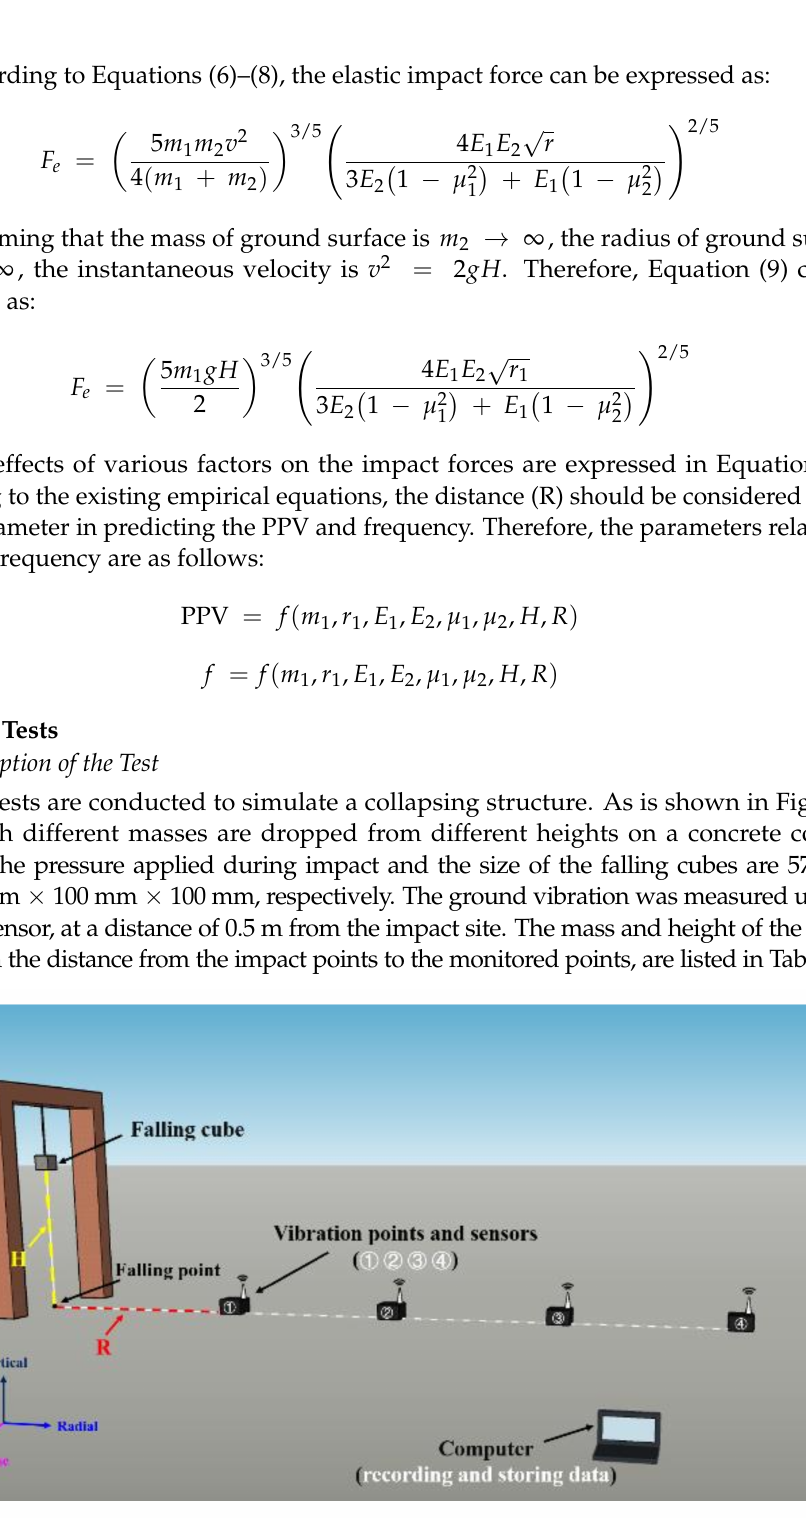
Figure 2. Experimental setup for fall tests and ground vibration measurements. Table 2. The range of the parameters of falling